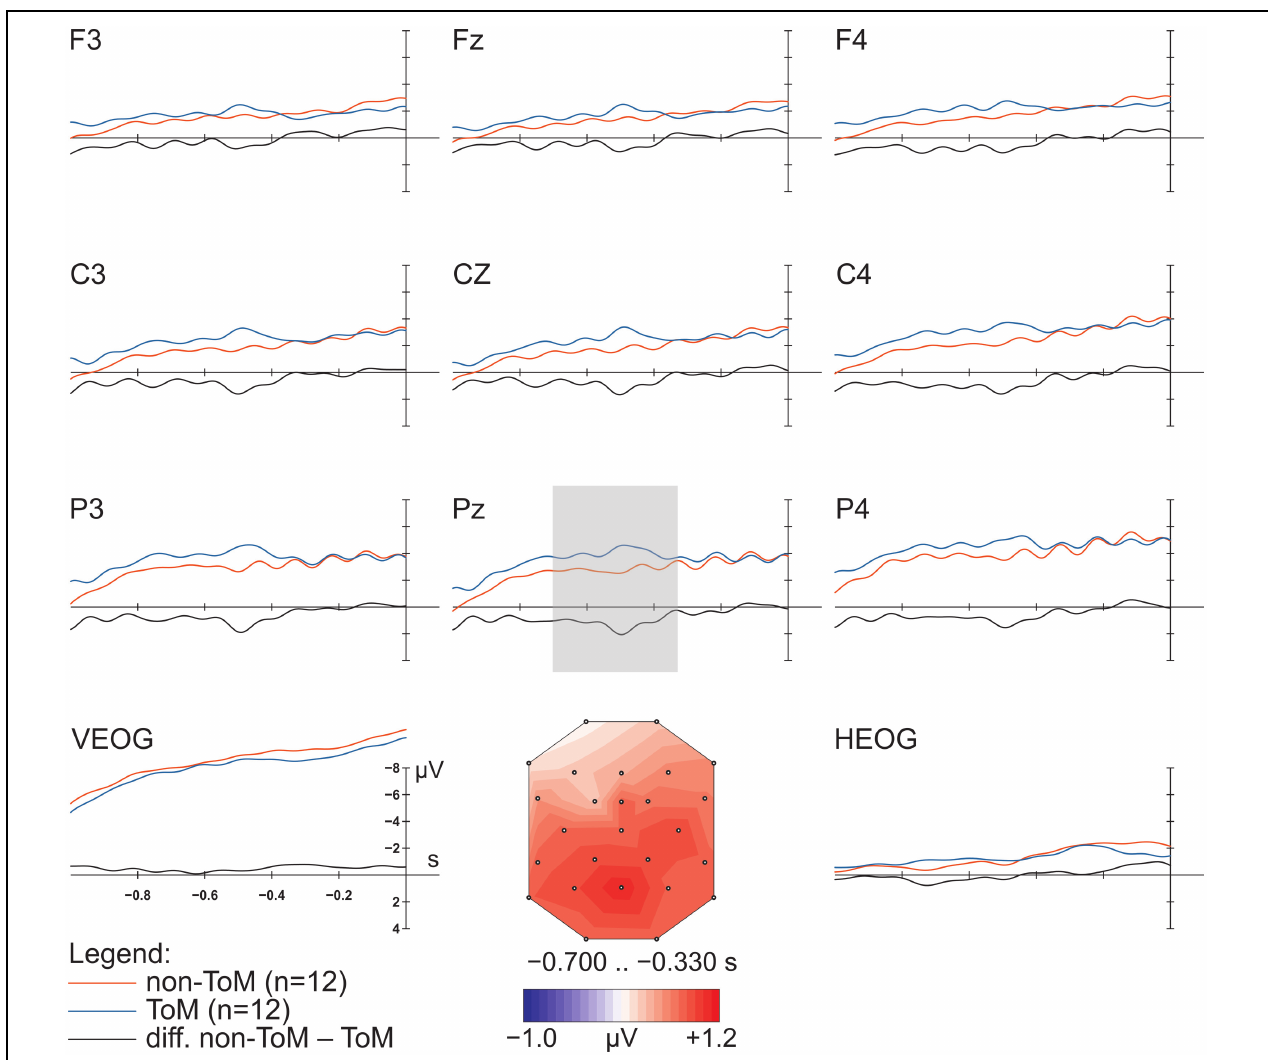
FIGURE 3 | Grand-average ERP waveforms, referenced to the nose, elicited at nine scalp electrodes and two EOG channels during preparation period time-locked to picture onset. Voltage map representing the difference between the non-ToM and ToM condition during the time interval 0.700 to 0.330 s before picture onset. Illustrated are waveforms for the two conditions (non-ToM, ToM) and the difference wave (non-ToM − ToM). The time interval used to plot the voltage map is indicated by a gray shade (shown at electrode with highest mean amplitude